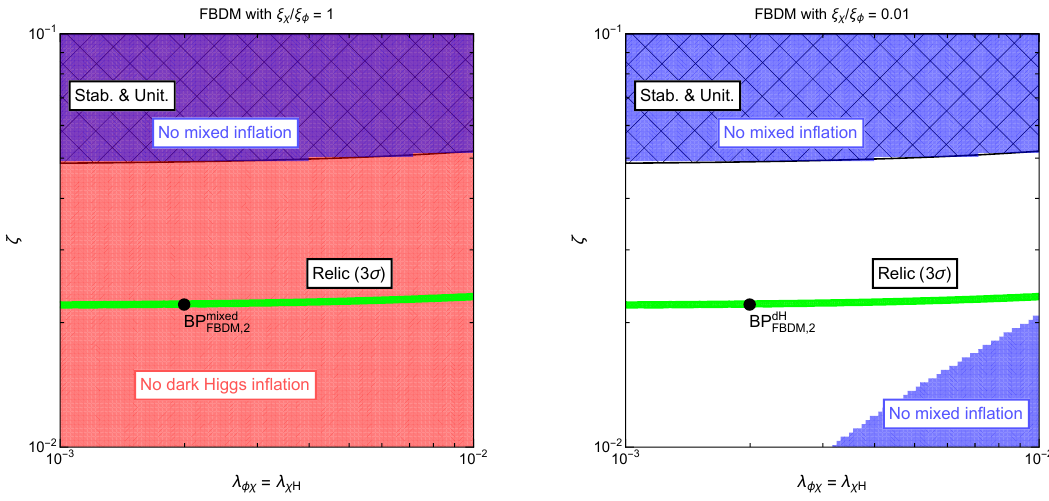
Figure 8 . Parameter space for forbidden dark matter scenario with (cid:24) (cid:31) =(cid:24) (cid:30) = 1 (left) and 0 : 01 (right) for (cid:21) (cid:30)(cid:31) = (cid:21) (cid:31)H versus (cid:16) . The parameters shown here are set at dark matter scale. The rest input parameters and color codes are as in (cid:12)gure 7, except that (cid:21) (cid:31) = (cid:21) (cid:30) = 0 : 055 and (cid:16) is varying.